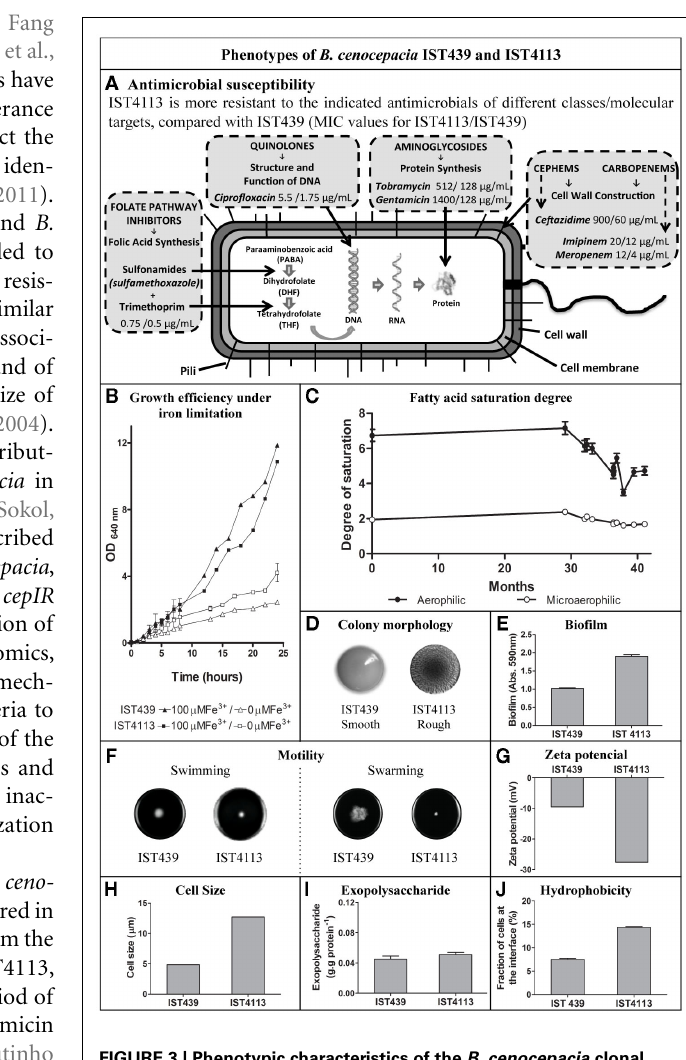
solute transporters) and low expressed genes/proteins. We